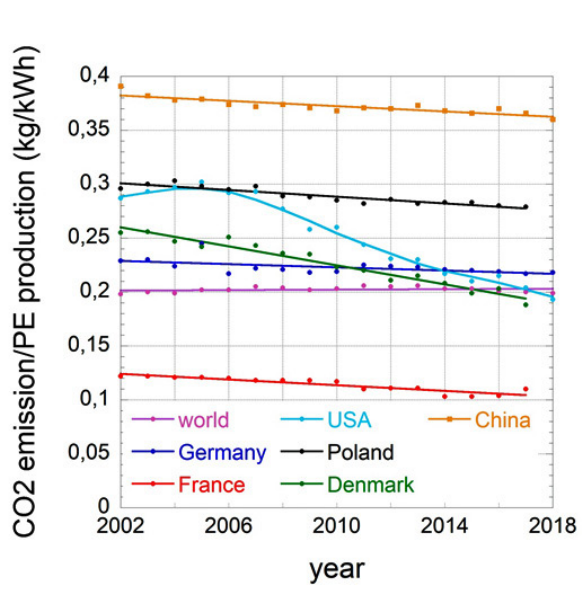
Fig. 6. – The ratio CO2 emission to primary energy ( PE ) production is used as a simple qualifier for the employed technology in all energy consuming sectors and plotted vs. time for various countries with quite different economic, technical, and societal background. The emission data are from OECD, the primary energy data from the German ministry of economy and